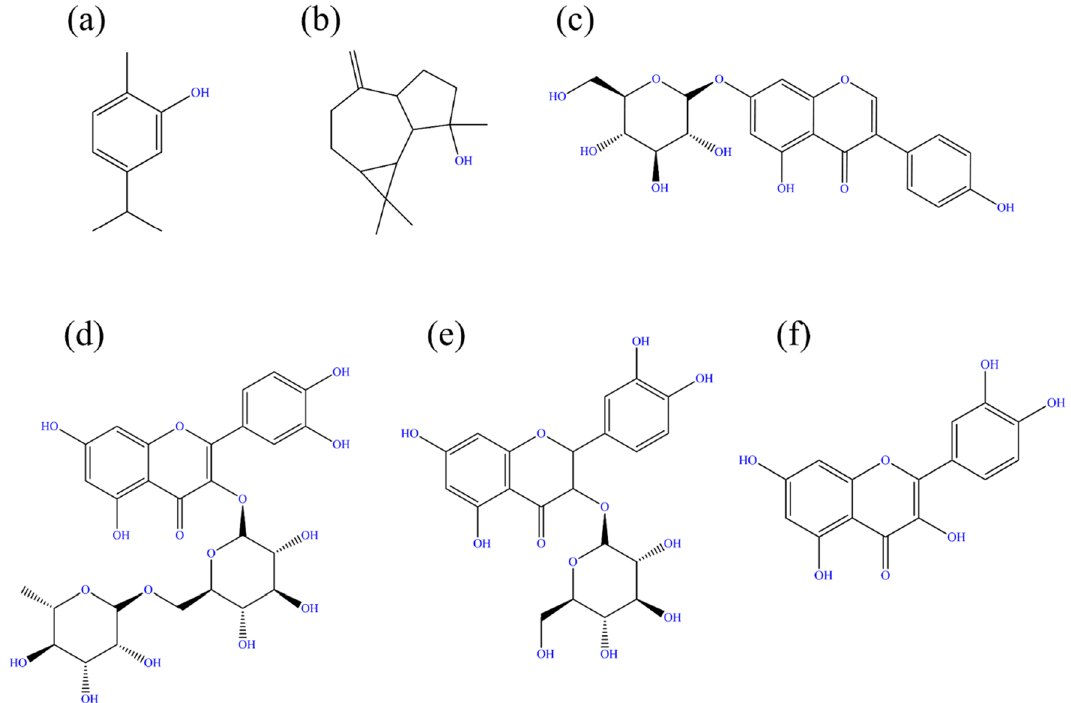
Figure 1. The chemical structure of Carvacrol ( a ), Spathulenol ( b ), Genistin ( c ), Rutin ( d ), Quercetin-3- O - glucoside ( e ), and Quercetin ( f